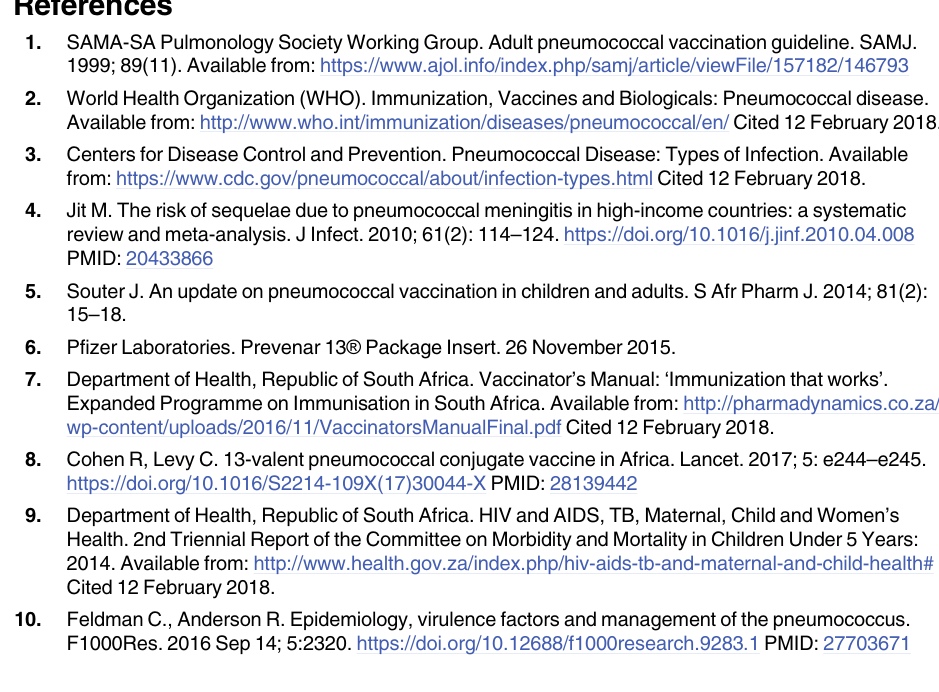
S11 Table. PSA detailed results: Private health care sector HIV-infected model. ICER, incremental cost-effectiveness ratio; WTP, willingness-to-pay; SE, South-East; NE, North-East; SW, South-West; NW, North-West; IC, incremental cost; IE, incremental effectiveness.